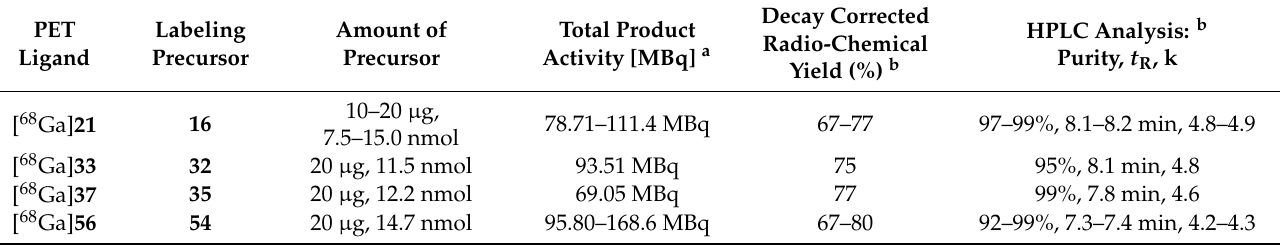
Table 1. PET ligand specific parameters for the radiosynthesis of [ 68 Ga] 21 , [ 68 Ga] 33 , [ 68 Ga] 37 and [ 68 Ga] 56